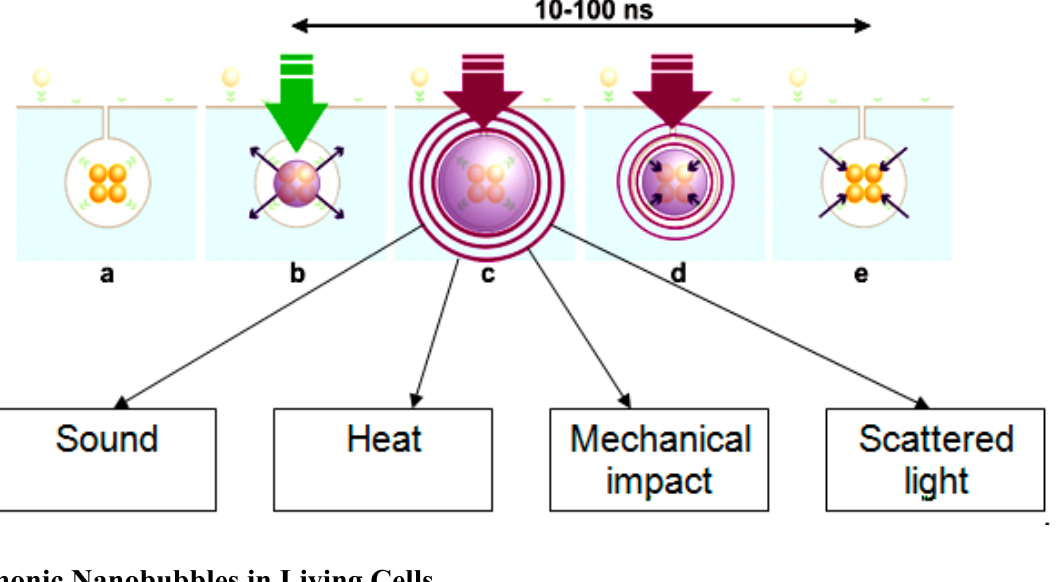
Figure 1. The mechanism of optical generation and detection of a plasmonic